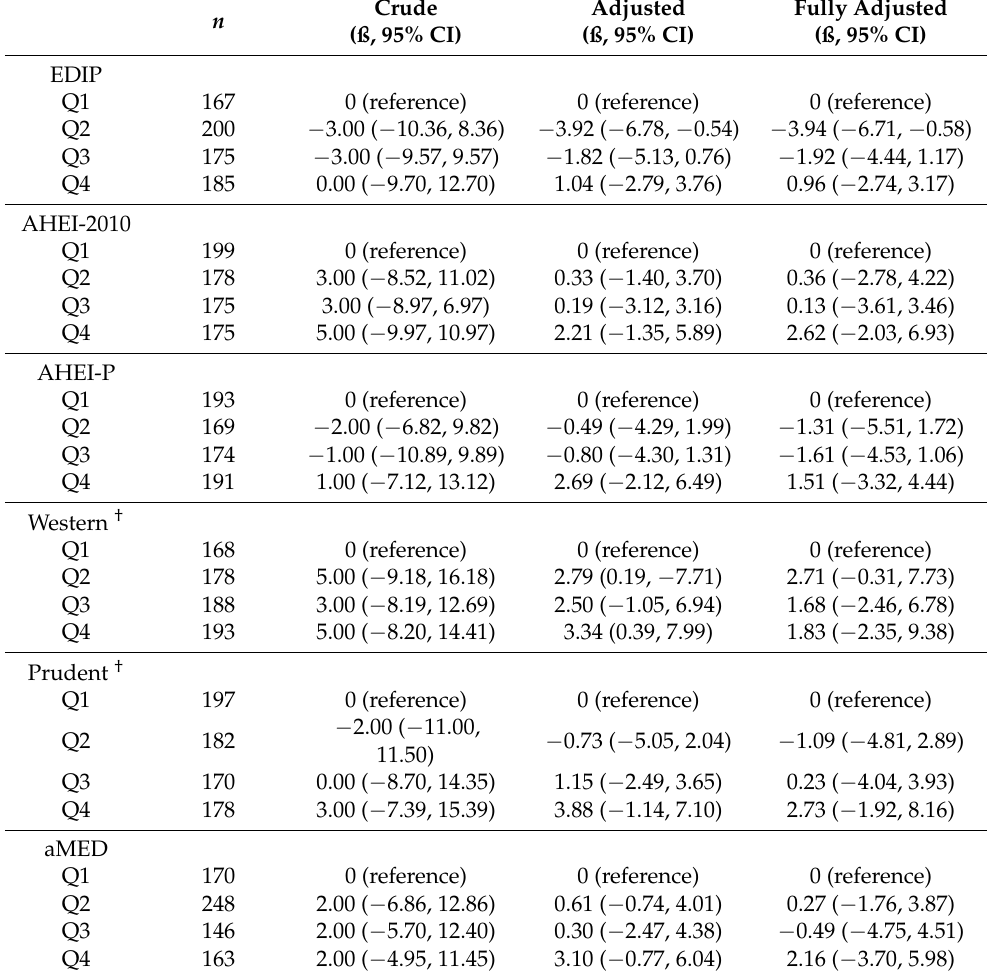
Table 3. Association between maternal dietary patterns and child SRS raw scores in the NHSII ( n =